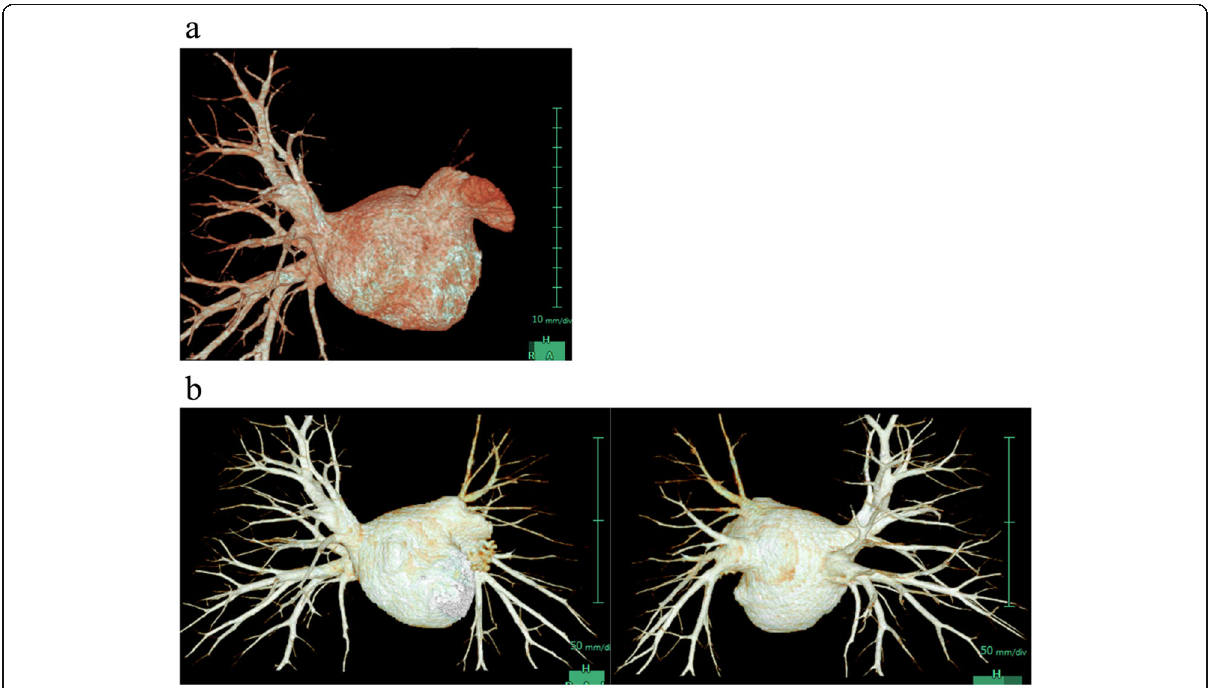
Fig. 2 a Preoperative CT: The left PV was completely occluded at the connfluence. b Postoperative CT: The upper and lower branches were relatively narrow but both